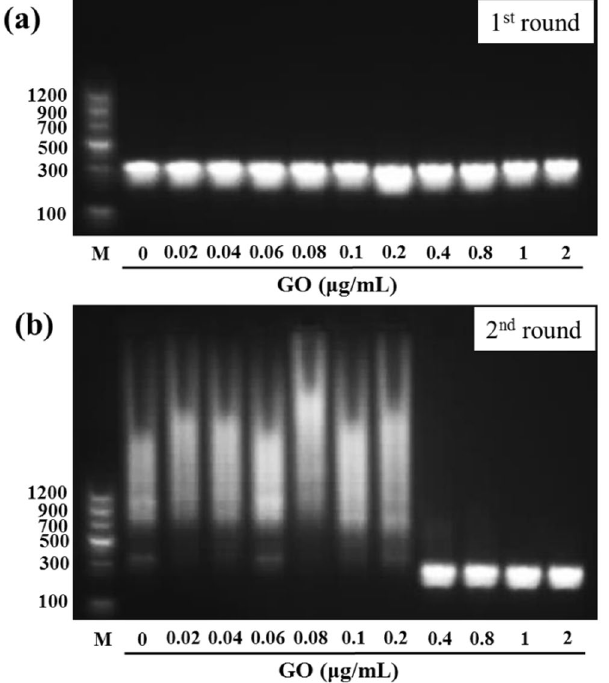
Figure 2. The effect of GO on first-round ( a ) and second-round ( b ) PCR. PCR was performed by employing a 283 bp target sequence from Lambda DNA template, and PCR products were analyzed by agarose gel electrophoresis (1.5%). Lane M is markers.